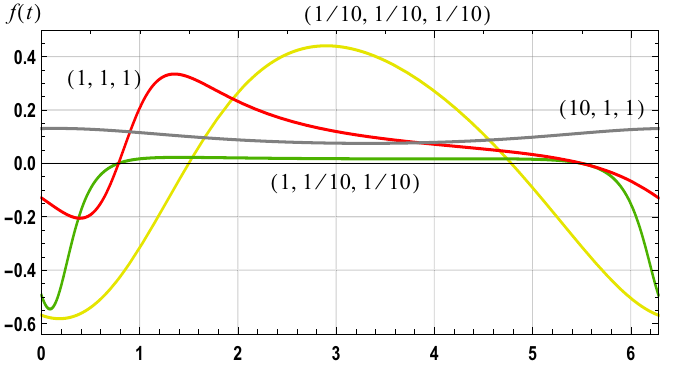
Figure 16. Graph of f ( t ) for the case of a = 1, b = 0. For the case of (10, 1, 1) a scaling factor of 10 has been used; for the case of (1, 1 / 10, 1 / 10) a scaling factor of 0.1 has been used.